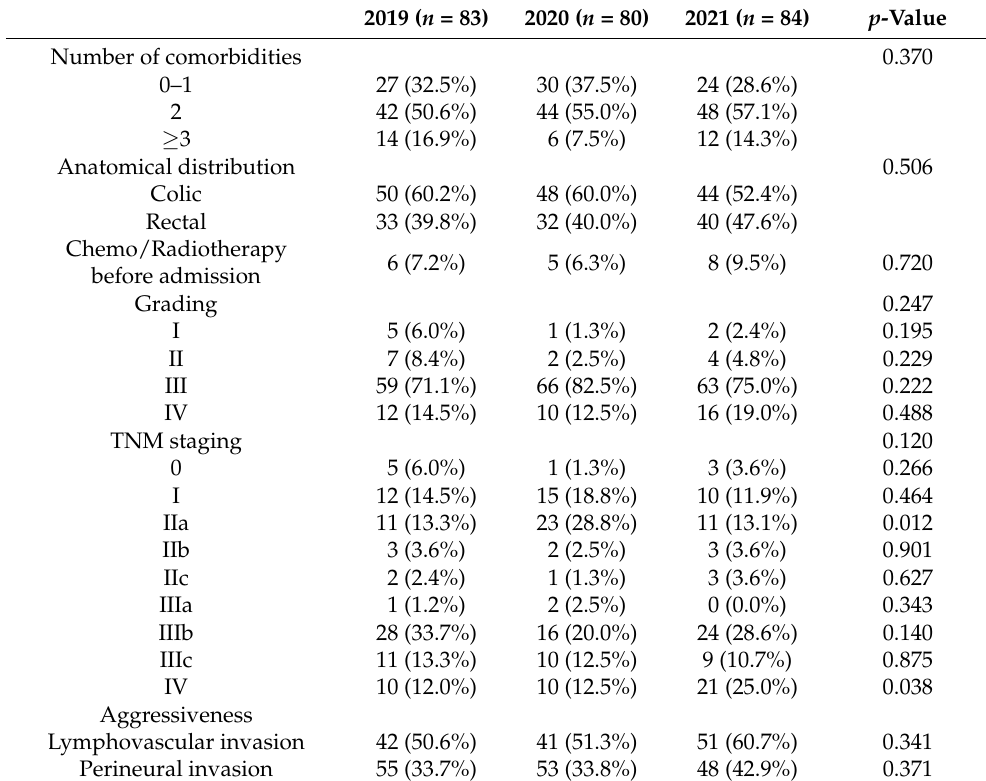
Table 2. Comparison of colorectal cancer characteristics during the study period.